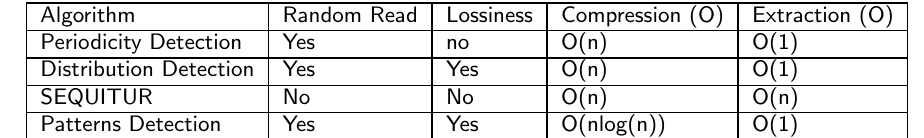
Table 2: A comparison of the different tested compression methods for data memory addresses